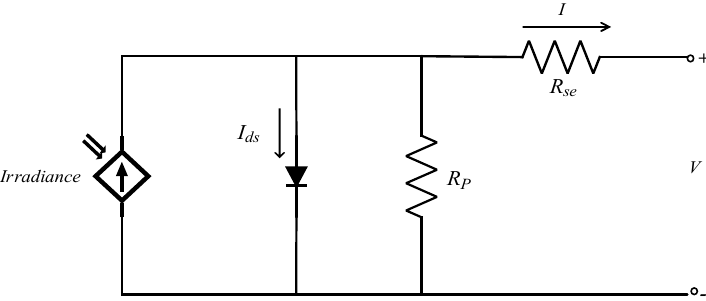
Figure 1. Equivalent circuit of the single-diode model.